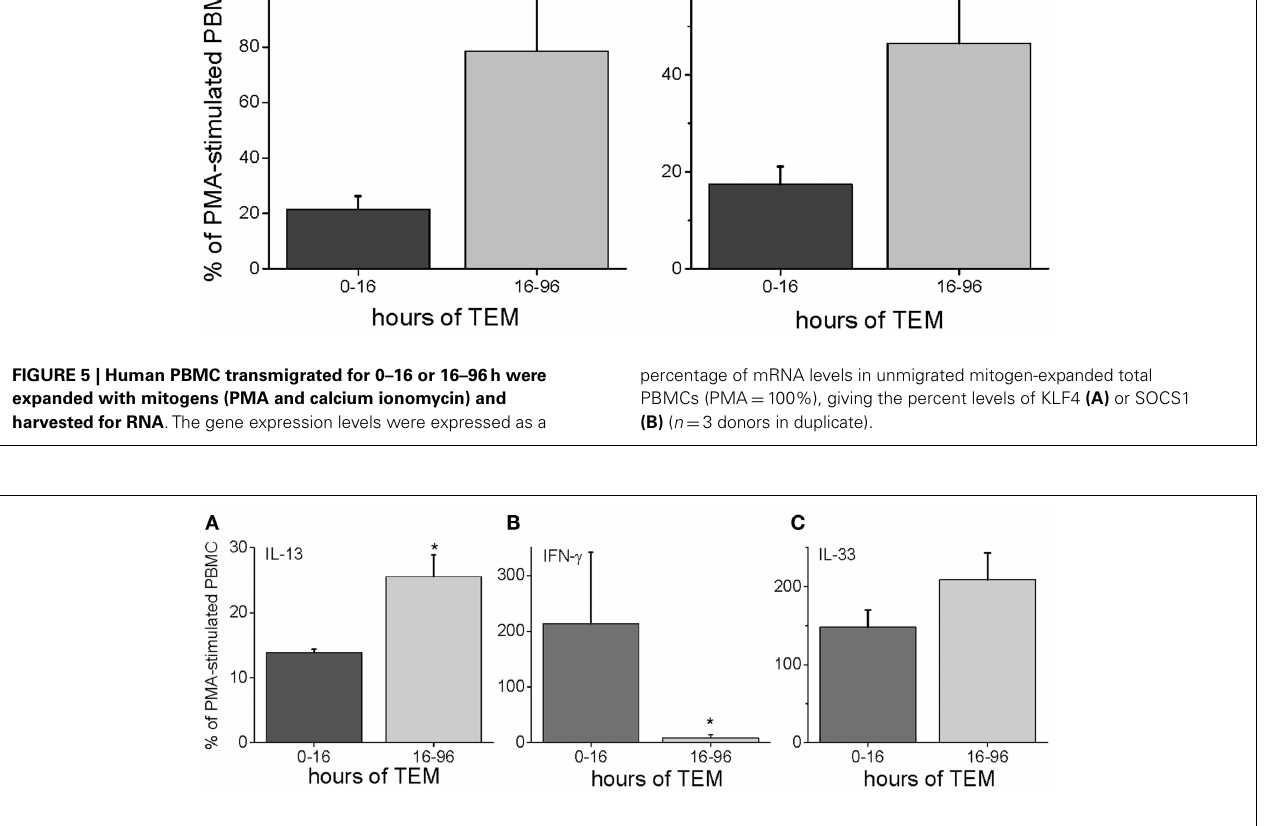
FIGURE 6 | Human PBMC transmigrated for 0–16 or 16–96h were expanded with mitogens and harvested for RNA .Their gene expression levels were expressed as a percentage of mRNA levels in unmigrated